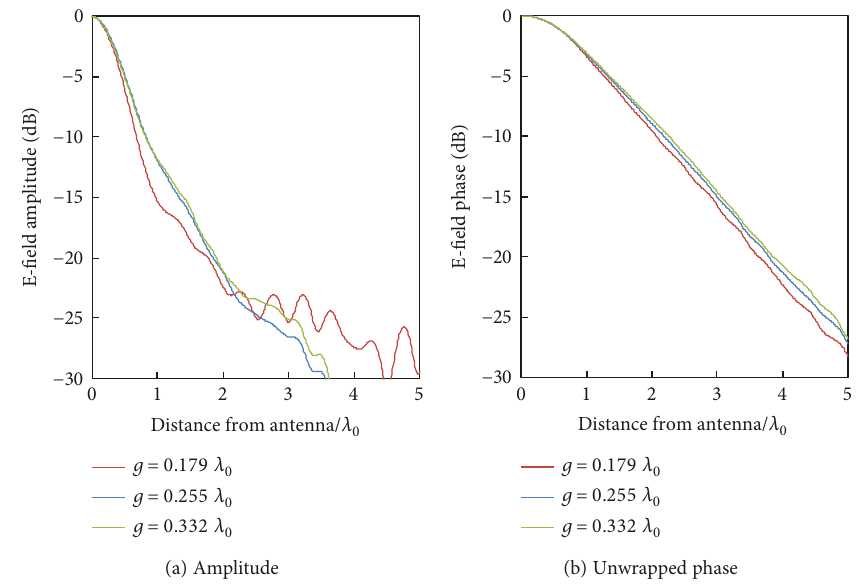
Figure 8: Normalized e- fi eld intensity distribution for the di ff erent corrugation periods.